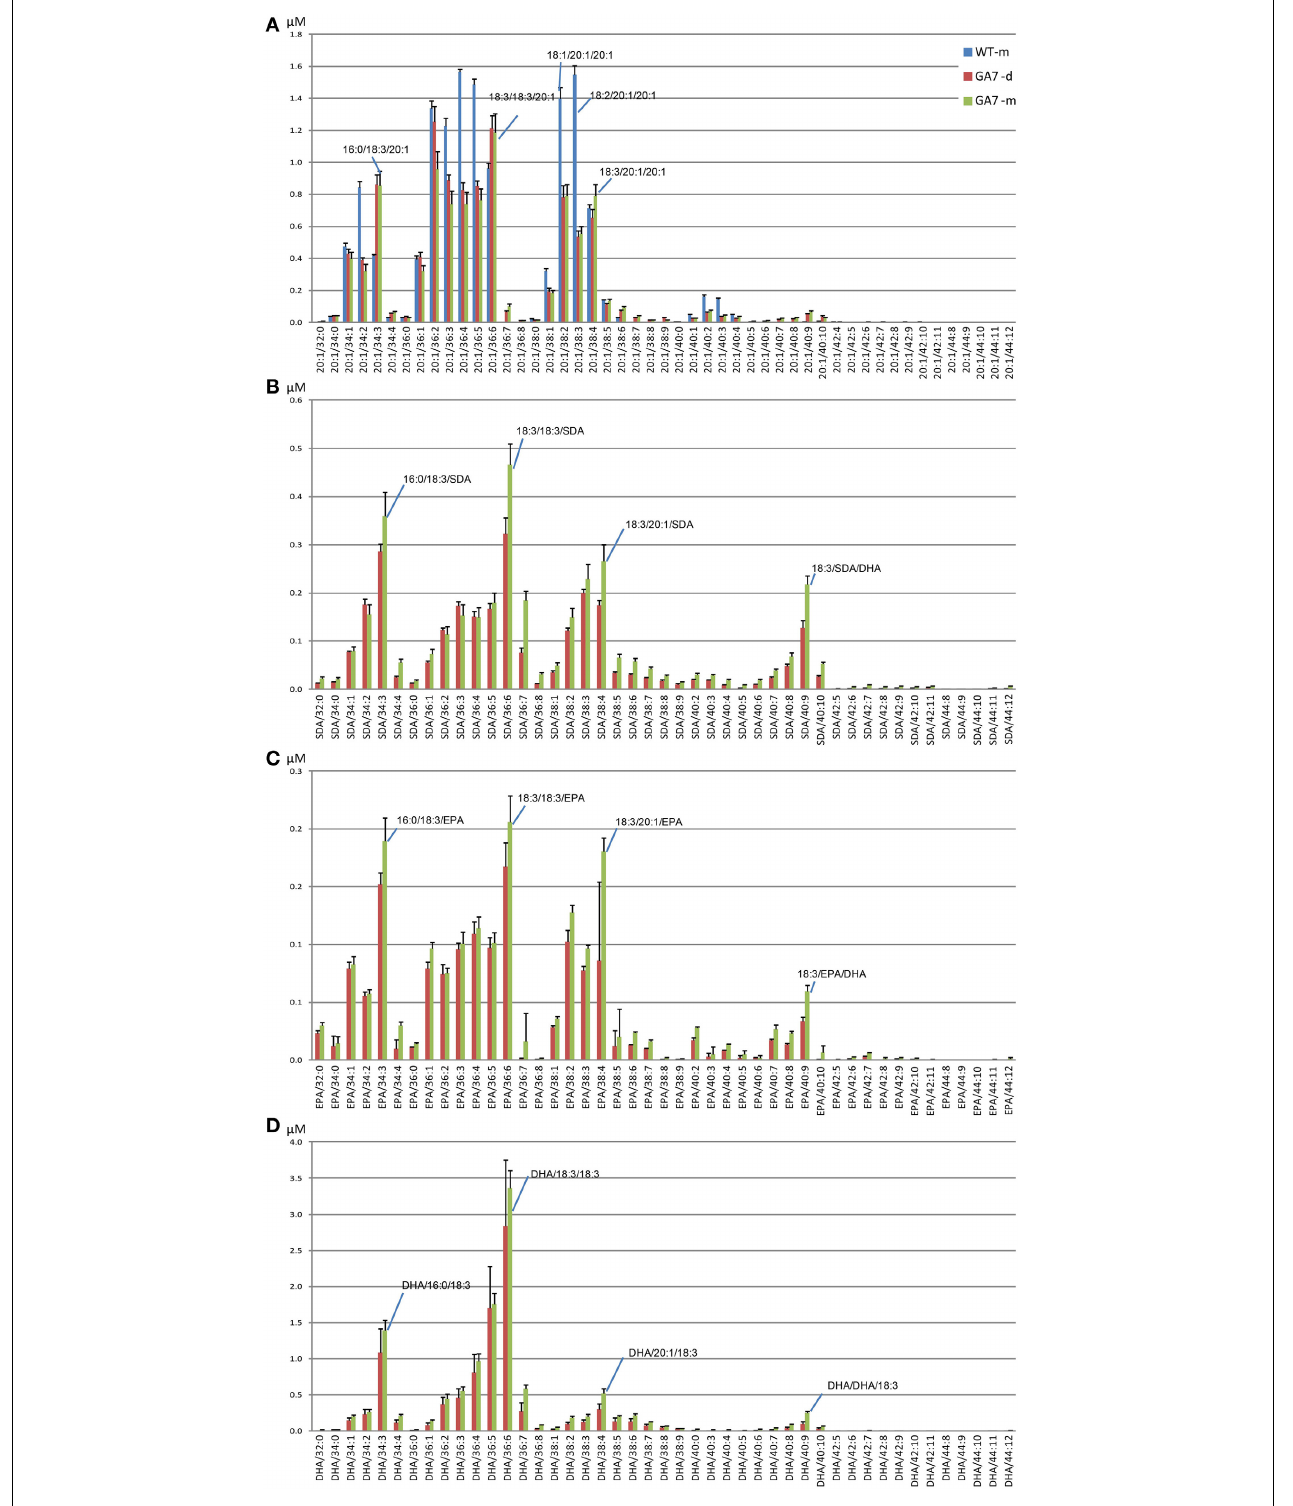
FIGURE 8 | Abundance of different triacylglycerol (TAG) species in the control (WT) and the transgenic (GA7) Arabidopsis seeds. TAG species are labeled in the format of TAG containing target/X:Y, where target will be 20:1 (A) , SDA (B) , EPA (C) or DHA (D) , with the other two acyl chains